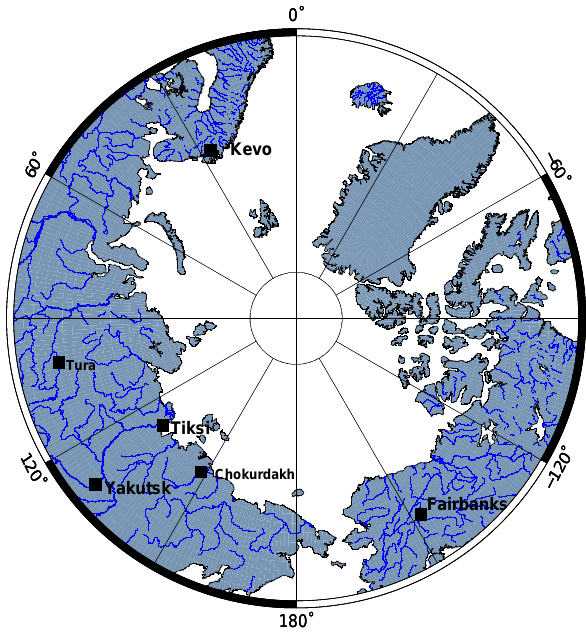
Figure 3. Location map of the GRENE-TEA